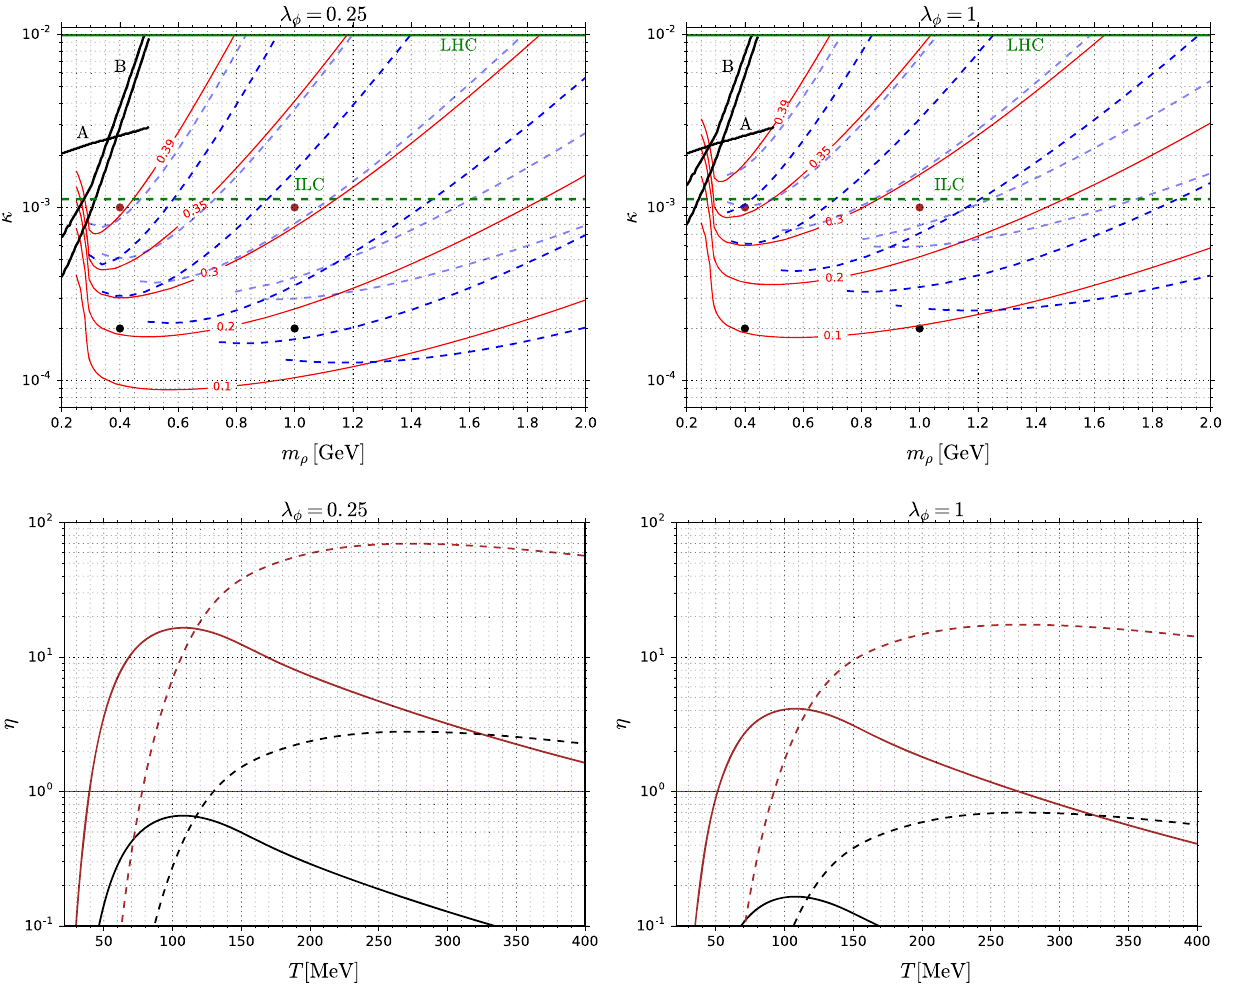
Fig. 1 Top: contour lines of constant (cid:3) N eff in ( m ρ , κ ) plane for λ φ = 0 . 25 (left panel) and λ φ = 1 (right panel) obtained with Eq. (48) in Maxwell-Boltzmann approximation (dark/light blue dashed lines include annihilation into muons and pions/muons only) and Eq. (12) with full particles statistics (red lines – see details in Sect. 4.2). Black lines correspond to astrophysical bounds [26]: for Goldstone boson free-streaming out of the proto-neutron stars (A) and for energy loss due to exotic species in SN 1987A in two different approximations